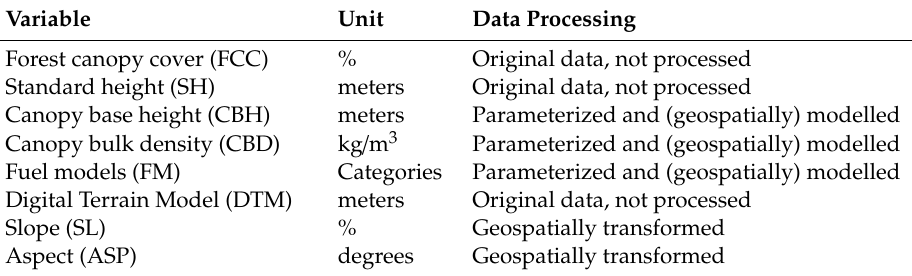
Table 1. List of variables used to generate the landscape file